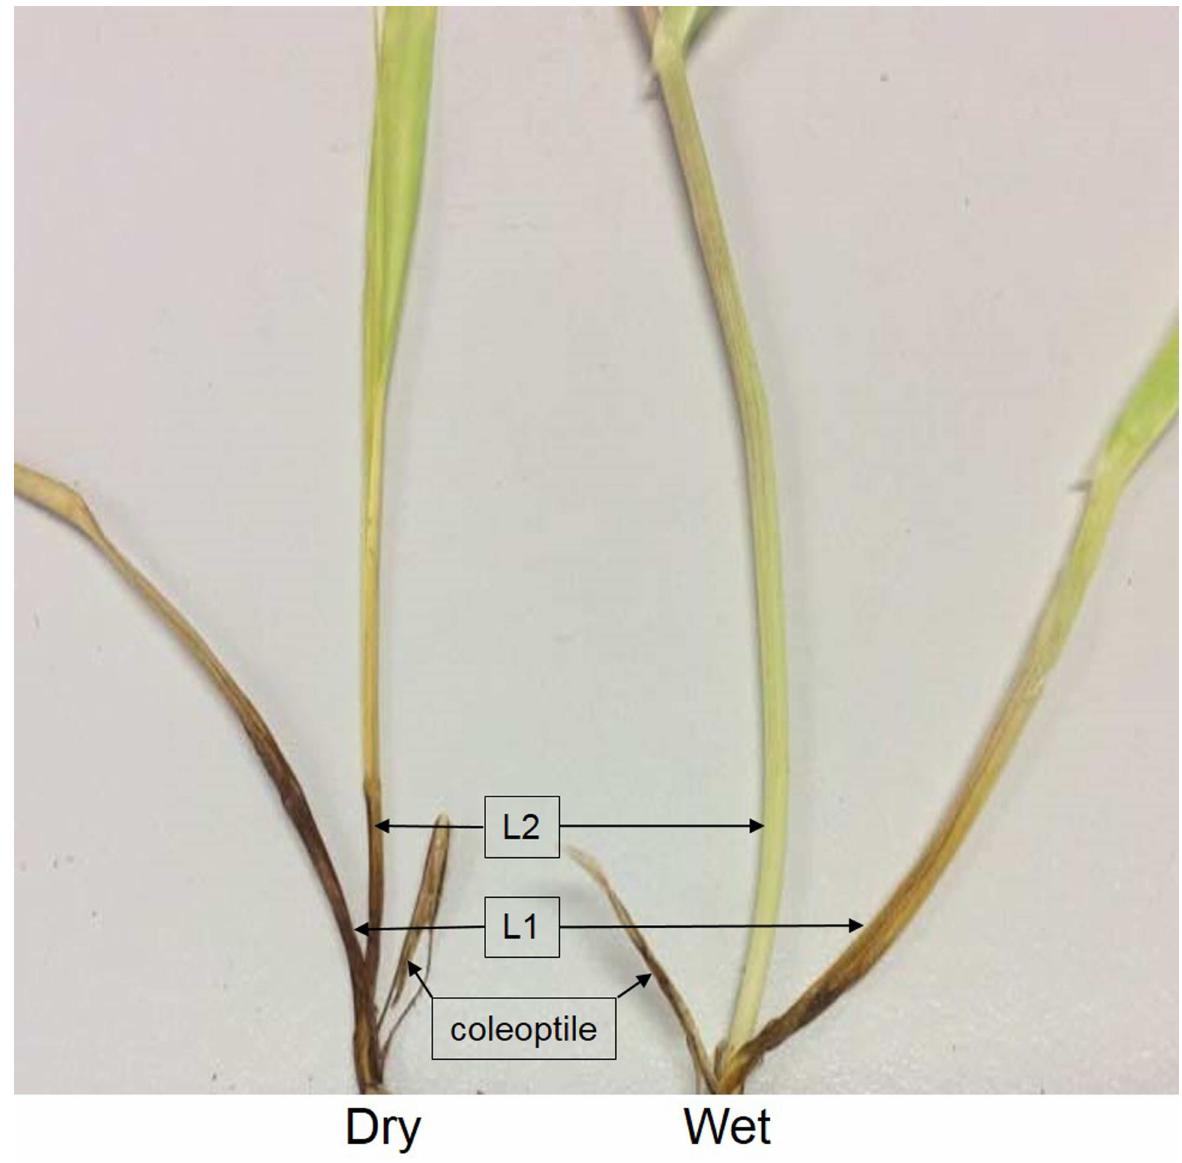
Fig 1. Showing typical difference in Fusarium crown rot severitybetween drought-stressed(left) and well-watered seedlings (right) of the susceptible barley genotype Fleet at 21 days post inoculation. L1: the first leaf sheath; L2: the second leaf